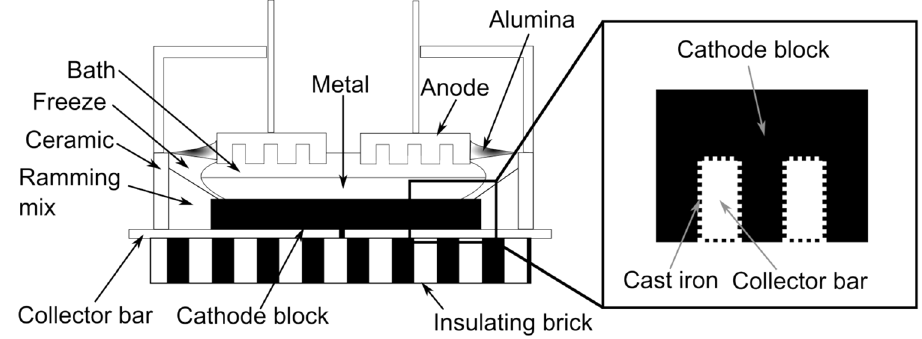
Fig. 1 General setup of an aluminium electrolysis cell. The enlarged part on the right shows the material compound of the cathode in a 90° rotated